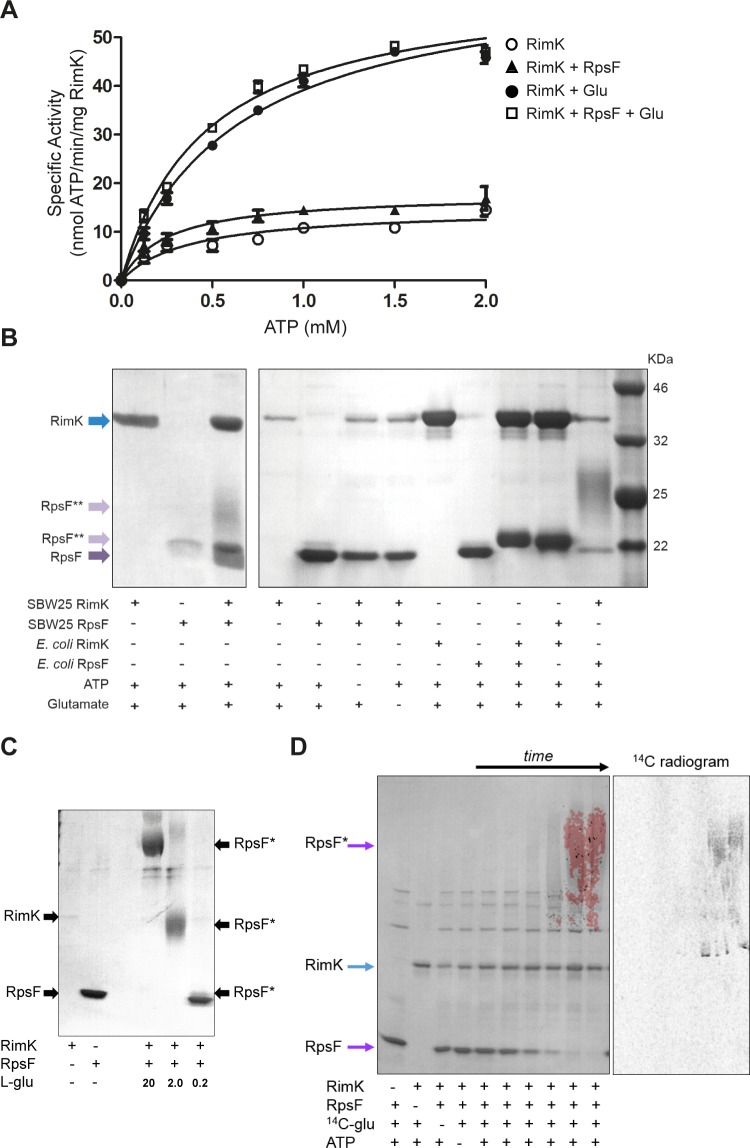
Biochemical analysis of RimK.3A. ATPase activity of RimKPf incubated with RpsFPf and glutamate. RimKPf specific activity (nmol ATP hydrolyzed/min/mg RimKPf) is shown for increasing concentrations of ATP (open circles). Addition of RpsFPf (triangles), glutamate (filled circles) or both (square) increases the Vmax of RimKPf ATPase activity. 3B. Glutamation assays with E. coli and SBW25 RimK and RpsF. The contents of each assay are indicated underneath the relevant lanes. Independent preparations of RimKPf and RpsFPf were used in the two panels, which were run separately and are shown side by side for comparative purposes only. Running positions of RimK, RpsF and glutamated-RpsF (RpsF**) are marked with arrows. 3C. Glutamation assays with RimKPf and RpsFPf. The contents of each assay are indicated, with 0.2, 2.0 and 20 mM glutamate added to the test samples as shown. Running positions of RimK, RpsF and glutamated-RpsF (RpsF*) are marked. 3D. Glutamation assays with RimKPf, RpsFPf and U-14C- glutamate. The contents of each reaction is indicated underneath the relevant lane. Control samples were incubated overnight, while time-course samples show 5, 10, 30, 60, 180 minutes, and overnight incubation. The left hand panel shows an overlay of Coomassie stained and radiolabel visualizations of a single gel. The right hand panel shows radiolabel incorporation into RpsF alone.